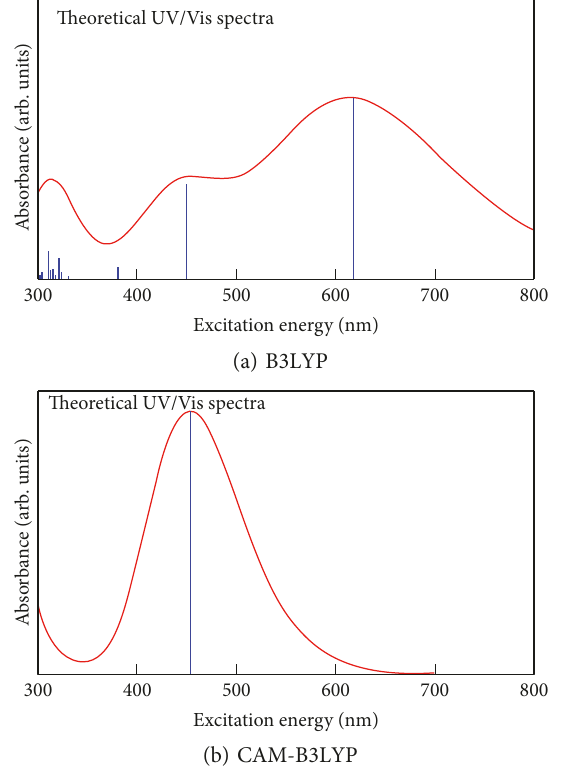
Figure 9: Theoretical UV/Vis spectra of the CL1-dye calculated within the B3LYP approximations to xc -functional showing a charge-transfer excitation energy of 618.4 nm (a) and CAM-B3LYP approximations showing a more accurate result of 453.6nm (b).